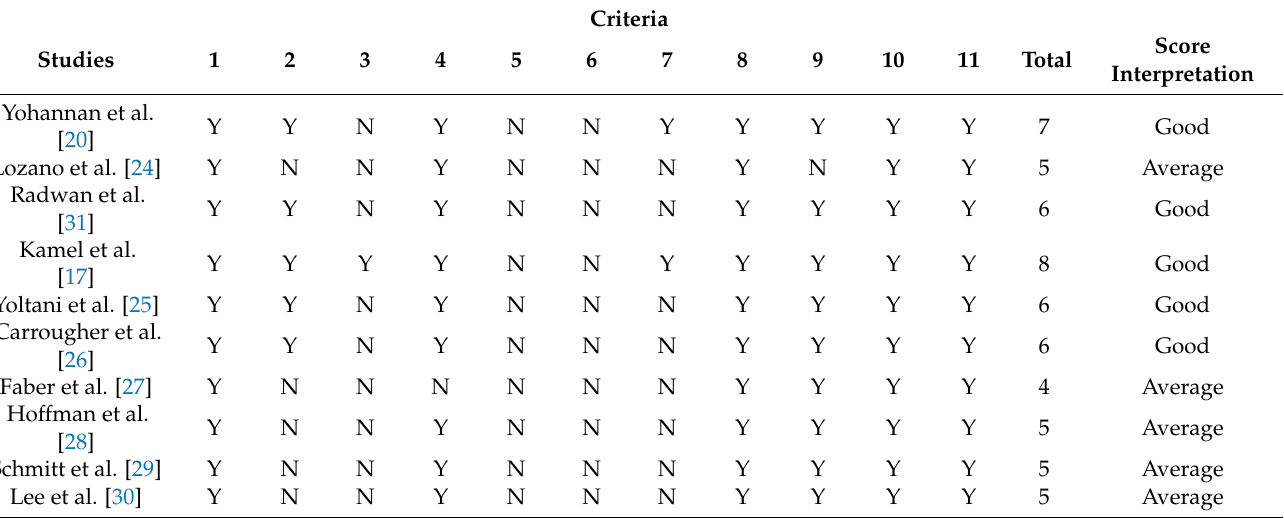
Table 3. Results of the methodological quality assessment with the Physiotherapy Evidence Database Scale